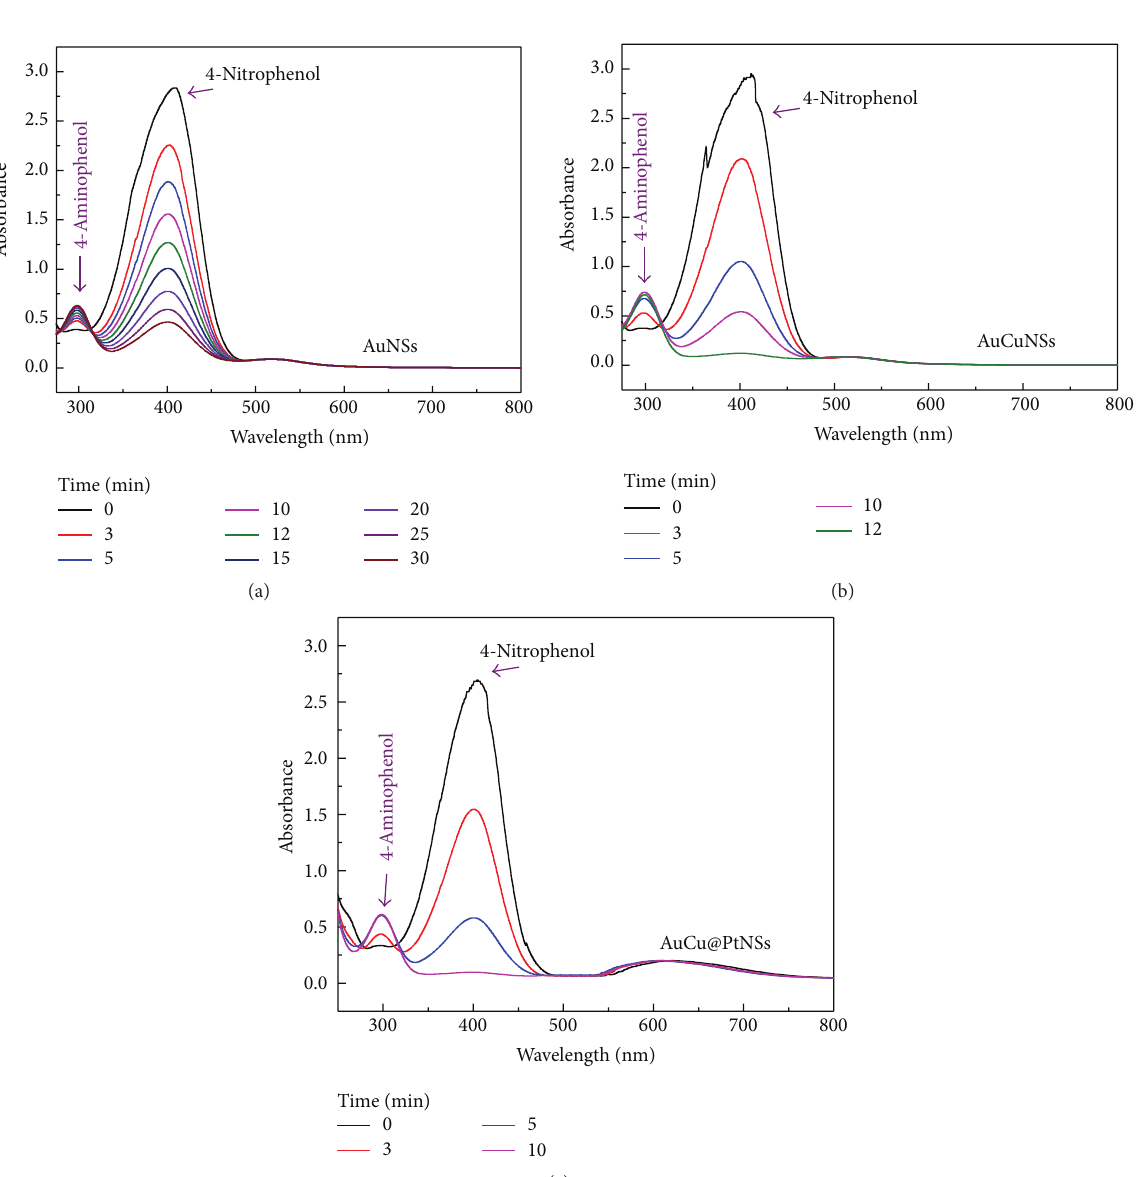
Figure 1: TEM of AuNSs (a) and AuCu@PtNSs (b).